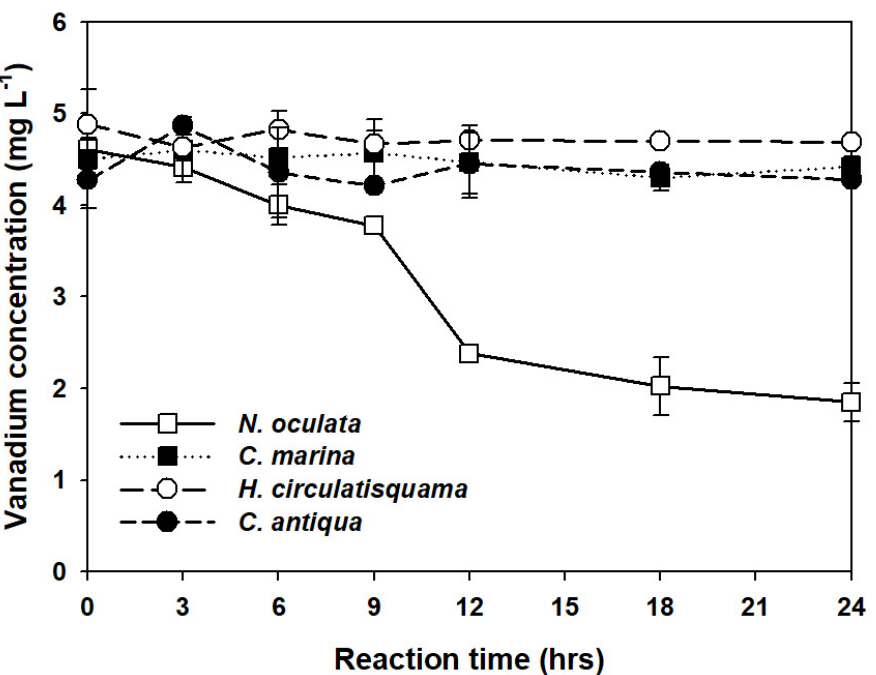
Figure 2. Vanadium ion concentration in the supernatant by ICP − MS after mixing with vanadium solution.